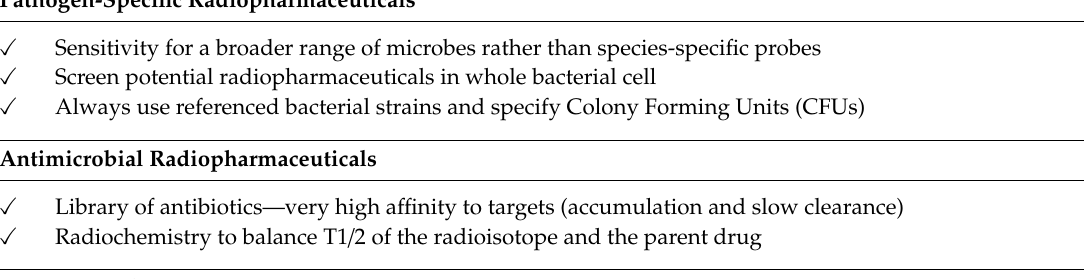
Table 1. Aspects to be considered for the improvement of bacteria imaging. Pathogen-Specific